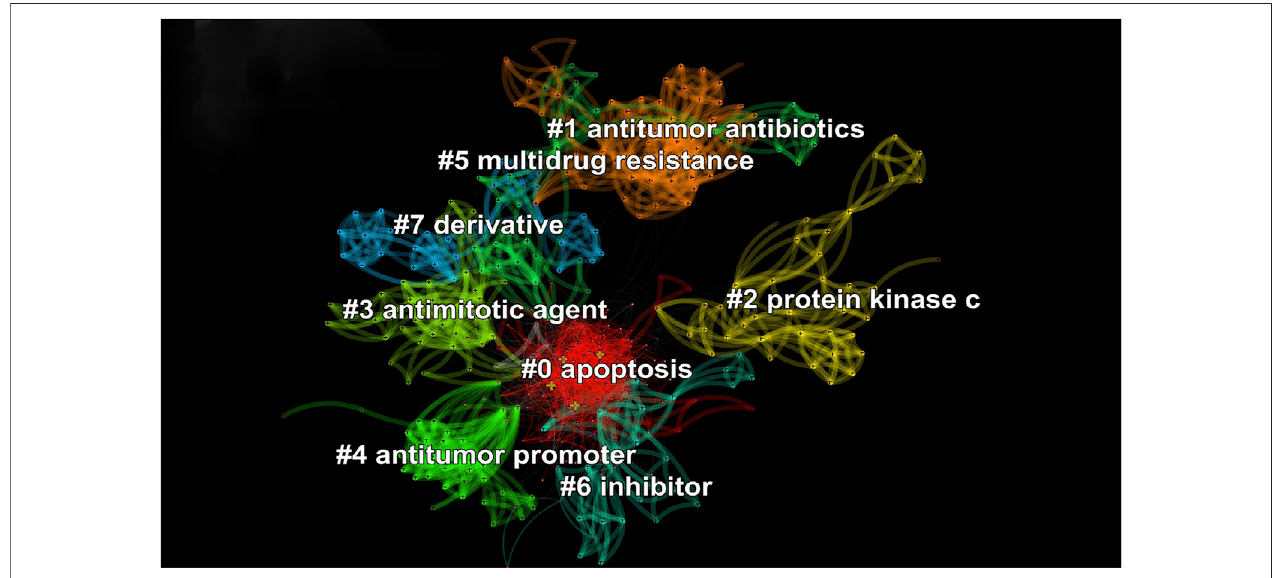
FIGURE 11 | Keyword clustering network of scienti fi c articles on anticancer natural products. Different colors mean different clusters. Anticancer natural products mainly focus on the themes “ apoptosis, ” “ derivative, ” “ antitumor antibiotics, ” “ multidrug resistance, ” , “ antimitotic agent, ” “ antitumor promoter, ” “ inhibitor, ” and “ protein kinase C. ”